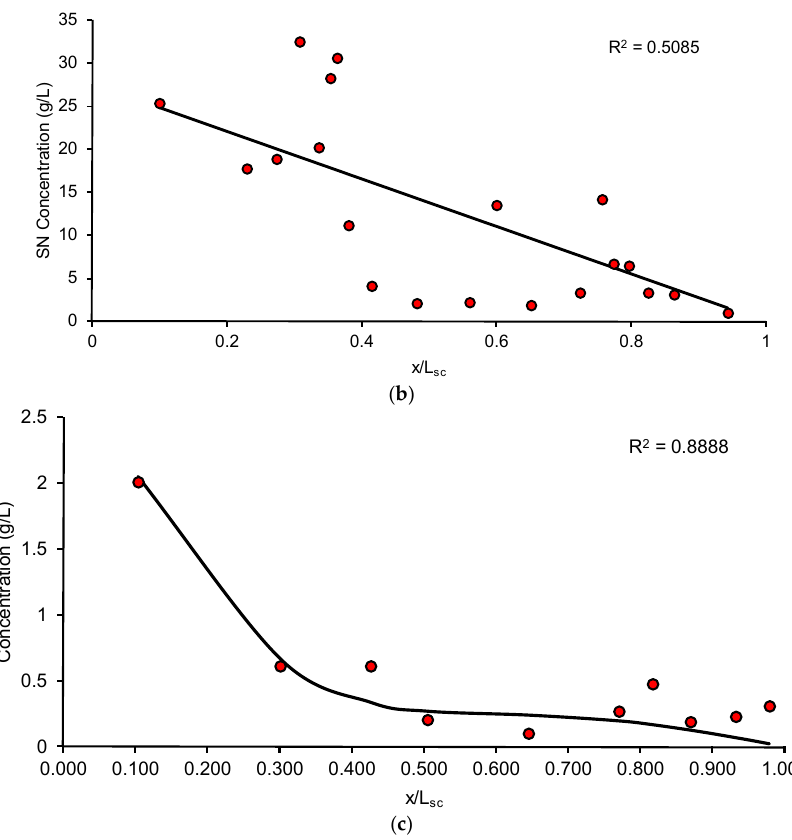
Figure 5. ( a ) Average SN concentration-depth profile following application of the formulation for 5 min and 24 h; ( b ) Sample fit for application of formulation for 24 h: markers are observed data and solid line is fit; ( c ) Sample fit for application of formulation for 5 min: markers are observed data and solid line is fit.